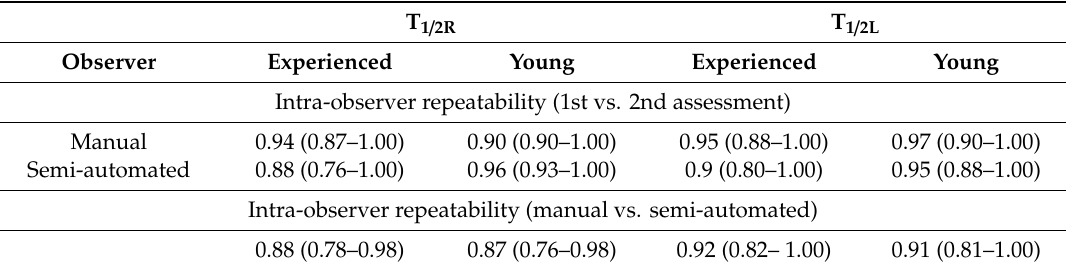
Table 7. Intra-observer repeatability for T 1 / 2 assessed by Fleiss’ kappa coe ffi cient. Continuous T 1 / 2 values were transformed to ordinal scale (1, 0–10 min; 2, 10–20 min; 3, ≥ 20 min) and weighted kappa (95% confidence interval) was calculated. T 1 / 2R T 1 / 2L